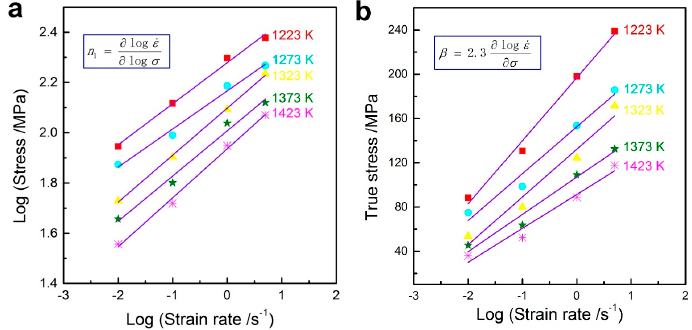
Figure 4. Correlation between flow stress and strain rate at various deformation temperatures: ( a ) log σ -log ε and ( b ) σ -log ε .